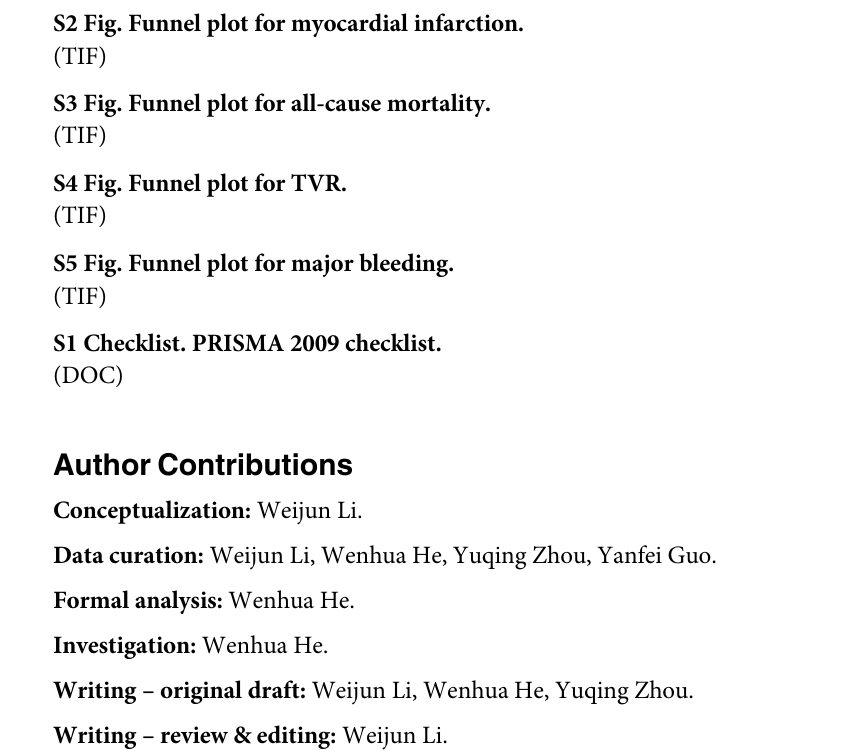
S2 Fig. Funnel plot for myocardial infarction. S3 Fig. Funnel plot for all-cause mortality. S4 Fig. Funnel plot for TVR. S5 Fig. Funnel plot for major